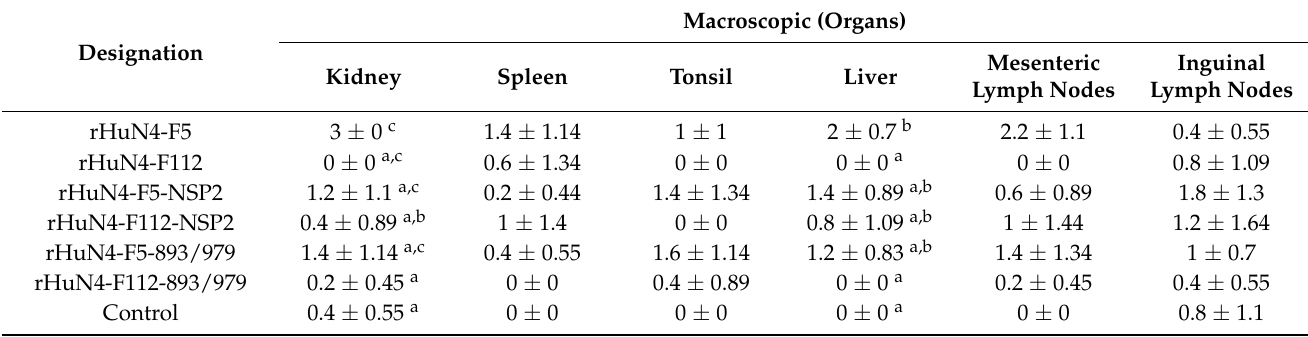
Table 3. Pathological examination of piglets infected with chimeric viruses.